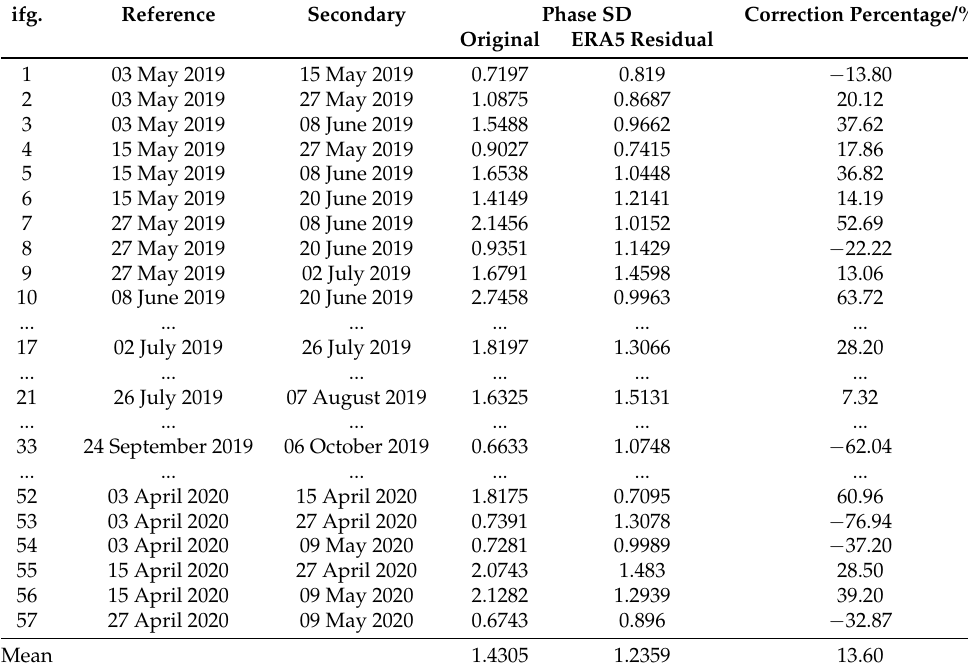
Table 1. Statistics using D-LOS mitigation model for 57 interferograms in study area. Correction percentage is calculated by the following equation: (Original − Residual)/Original.